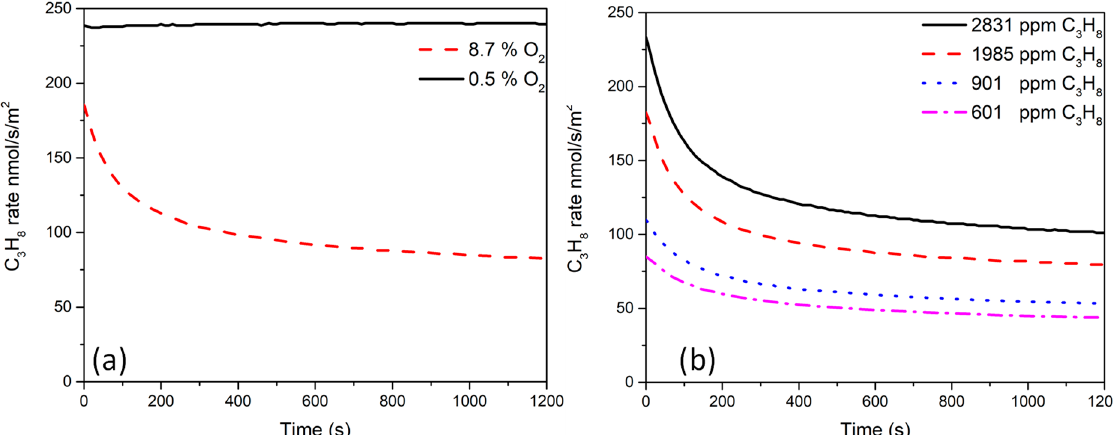
Figure 8. Variation of propane conversion as a function of time for Pd/CZP45-LS at 400 ◦ C ( a ) for two different oxygen concentrations using 1985 ± 9 ppm of C 3 H 8 and ( b ) for different C 3 H 8 concentrations using 8.7% ± 0.44% of O 2 .